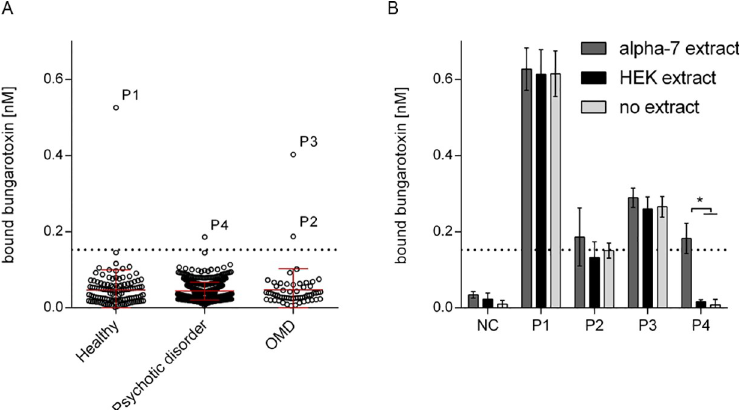
Fig 2. Radioimmunoassay for the detection of α 7 AChR antibodies in human sera. (A) Tested sera were from healthy individuals, patients with psychotic disorders, and patients with other mental disorders (OMD). Results represent the nM α -bungarotoxin precipitated by human sera. Error bars indicate the standard deviation. The dotted line indicates the cut-of level, defined by the mean of the healthy cohort plus 2 times the standard deviation. (B) Positive sera (above the cut-off level in panel A) were retested in the radioimmunoassay for α 7 AChR specificity, by performing the RIA with α 7 AChR membrane extract, membrane extract without α 7 AChR, and with lysis buffer only. These positive sera were named P1-P4 and a negative control (NC) was a serum sample with a consistently negative RIA result. Results are the means of triplicate measurements with standard deviation; � represents a p-value < 0.05 when performing multiple t-tests with Bonferroni